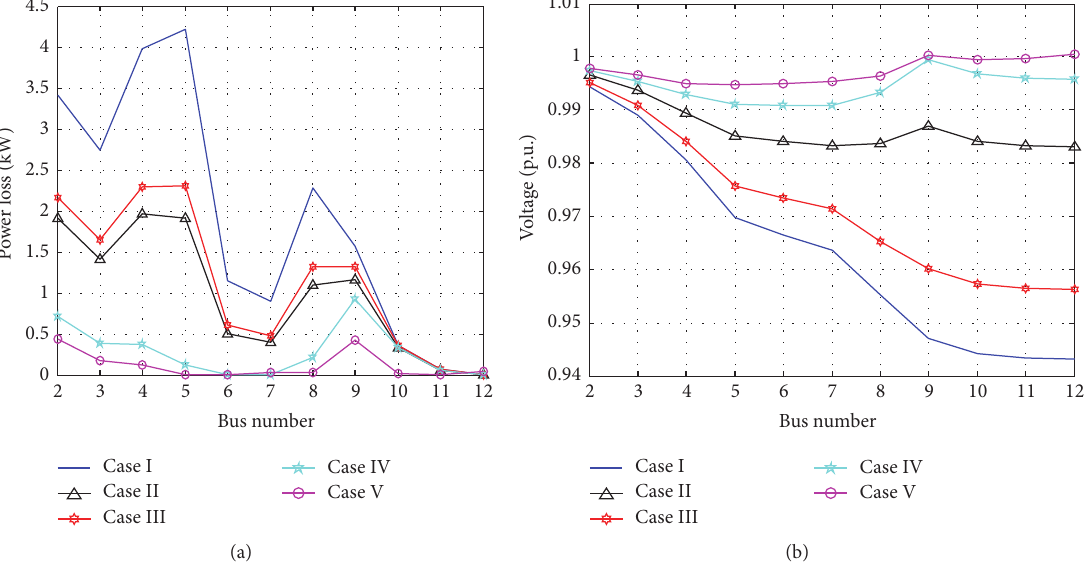
Figure 2: (a) Comparison of line losses for different cases in 12-bus system. (b) Comparison of voltage profile for different cases in 12-bus system.